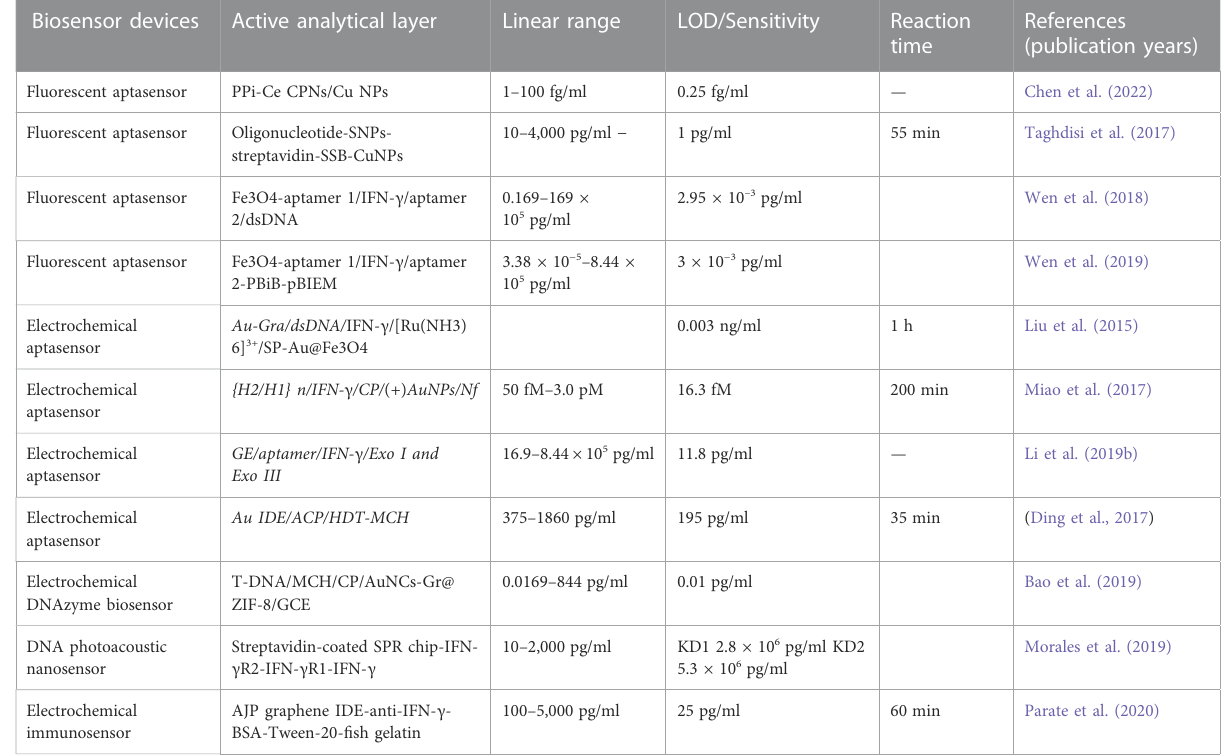
TABLE 2 Comparison of the analytical performance of nanobiosensors for the analysis of cytokines. Biosensor